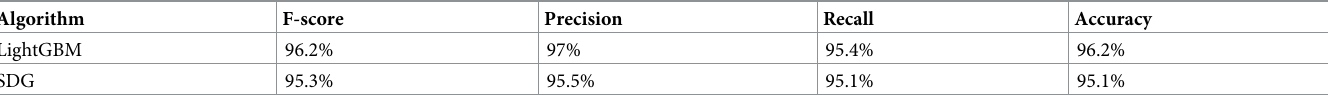
Table 3. All_D performance. Algorithm